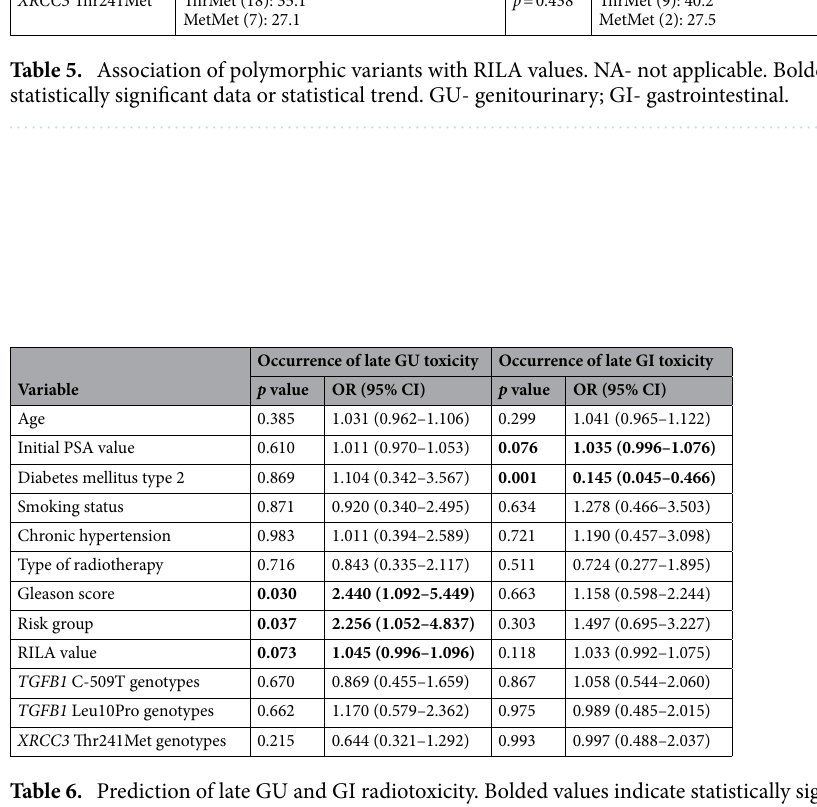
Table 6. Prediction of late GU and GI radiotoxicity. Bolded values indicate statistically significant data or statistical trend. GU- genitourinary; GI-